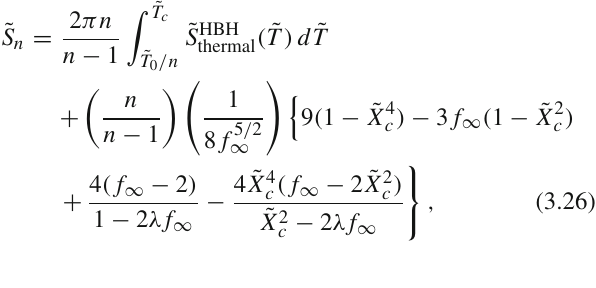
Fig. 8 Foreachpositivevalueofthe λ thereisatemperature, T v ,where the thermal entropy becomes